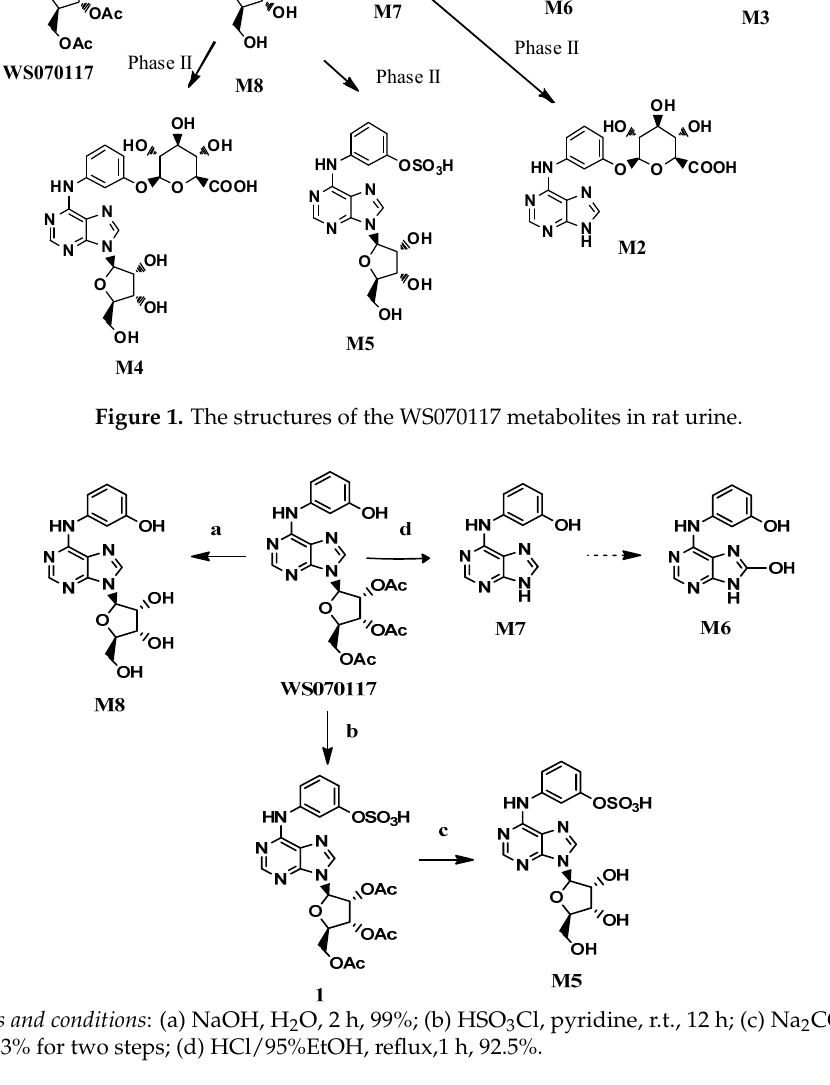
Scheme 2. The synthesis of M3 and M6 .